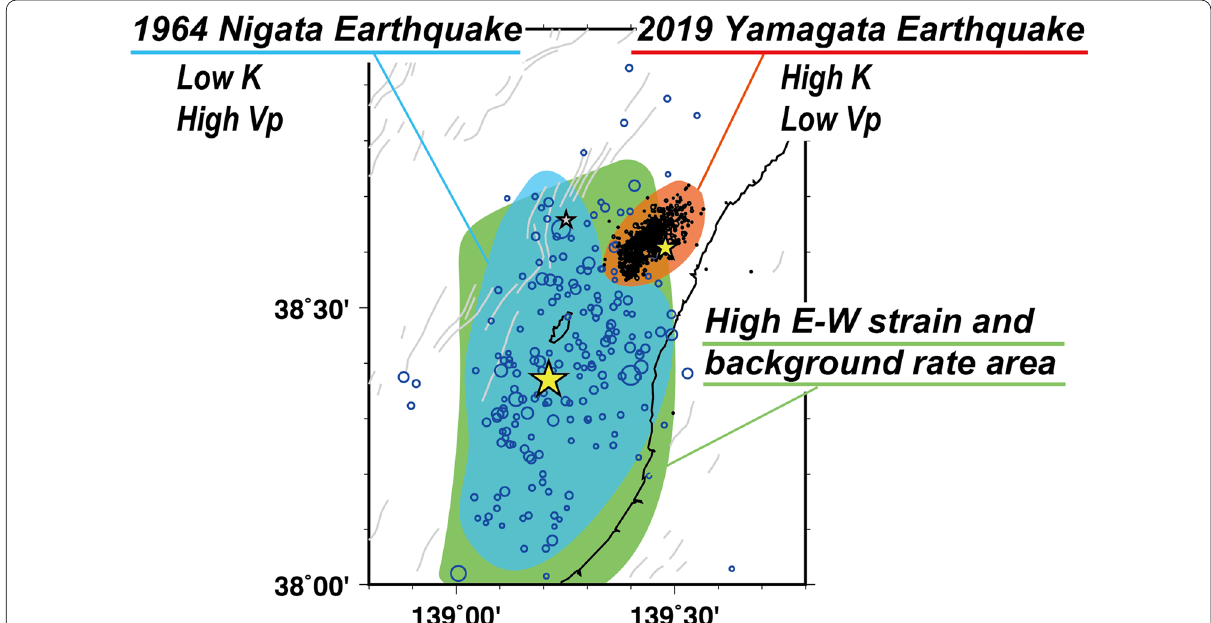
Fig. 5 Summary of the seismicity characteristics and geophysical features in the studied region. Black and yellow stars, blue circles, and gray lines are the same as in Fig. 1b. The black circles are the same as the red circles in Fig. 1b. See the text for further